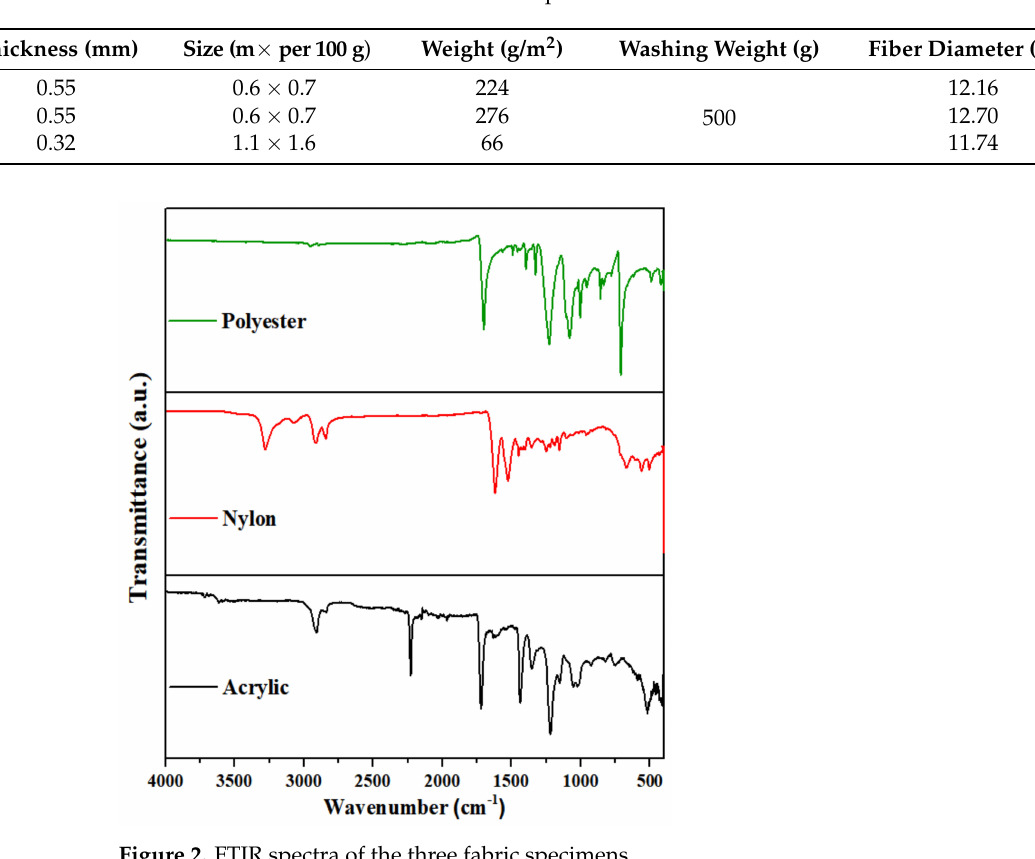
Figure 1. Images of the three fabric specimens. Front of single jersey fabrics consisting of ( a ) polyester knit, ( b ) nylon knit, and ( c ) acrylic knit. ( d ) The fabric construction of single jersey knit. Table 1. Characteristics of the three fabric specimens.